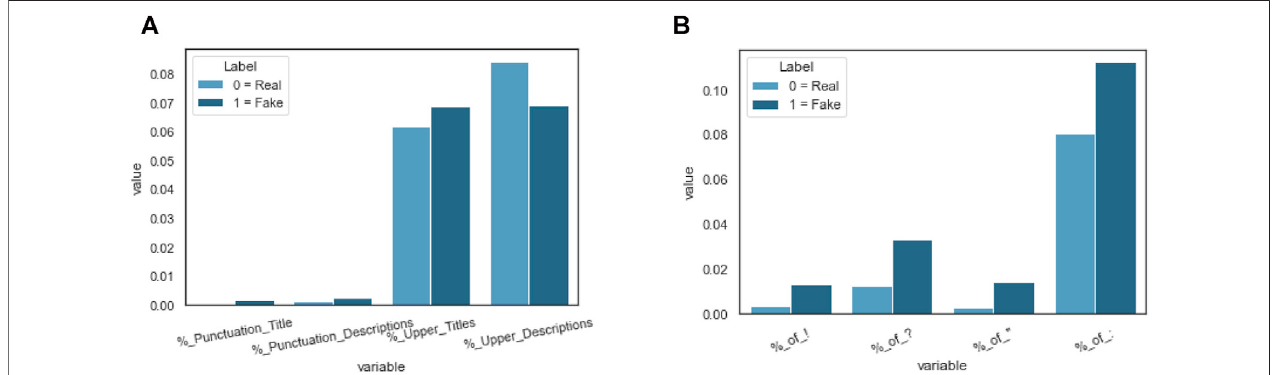
FIGURE 3 | Frequency of (A) punctuation characters and uppercase words in meta titles and descriptions and (B) some speci fi c punctuation characters (exclamation mark, question mark, quotes, and colons). With the exception of uppercase words that were used more frequently in meta descriptions, fake news has shown a higher percentage of punctuation in both titles and descriptions, probably by “ over-dramatising ” events; also, the use of uppercase characters in titles appears more evident in misleading content.